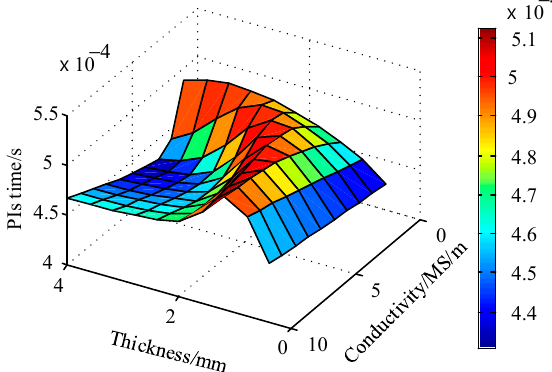
Figure 10. PIs time change with thickness and conductivity.